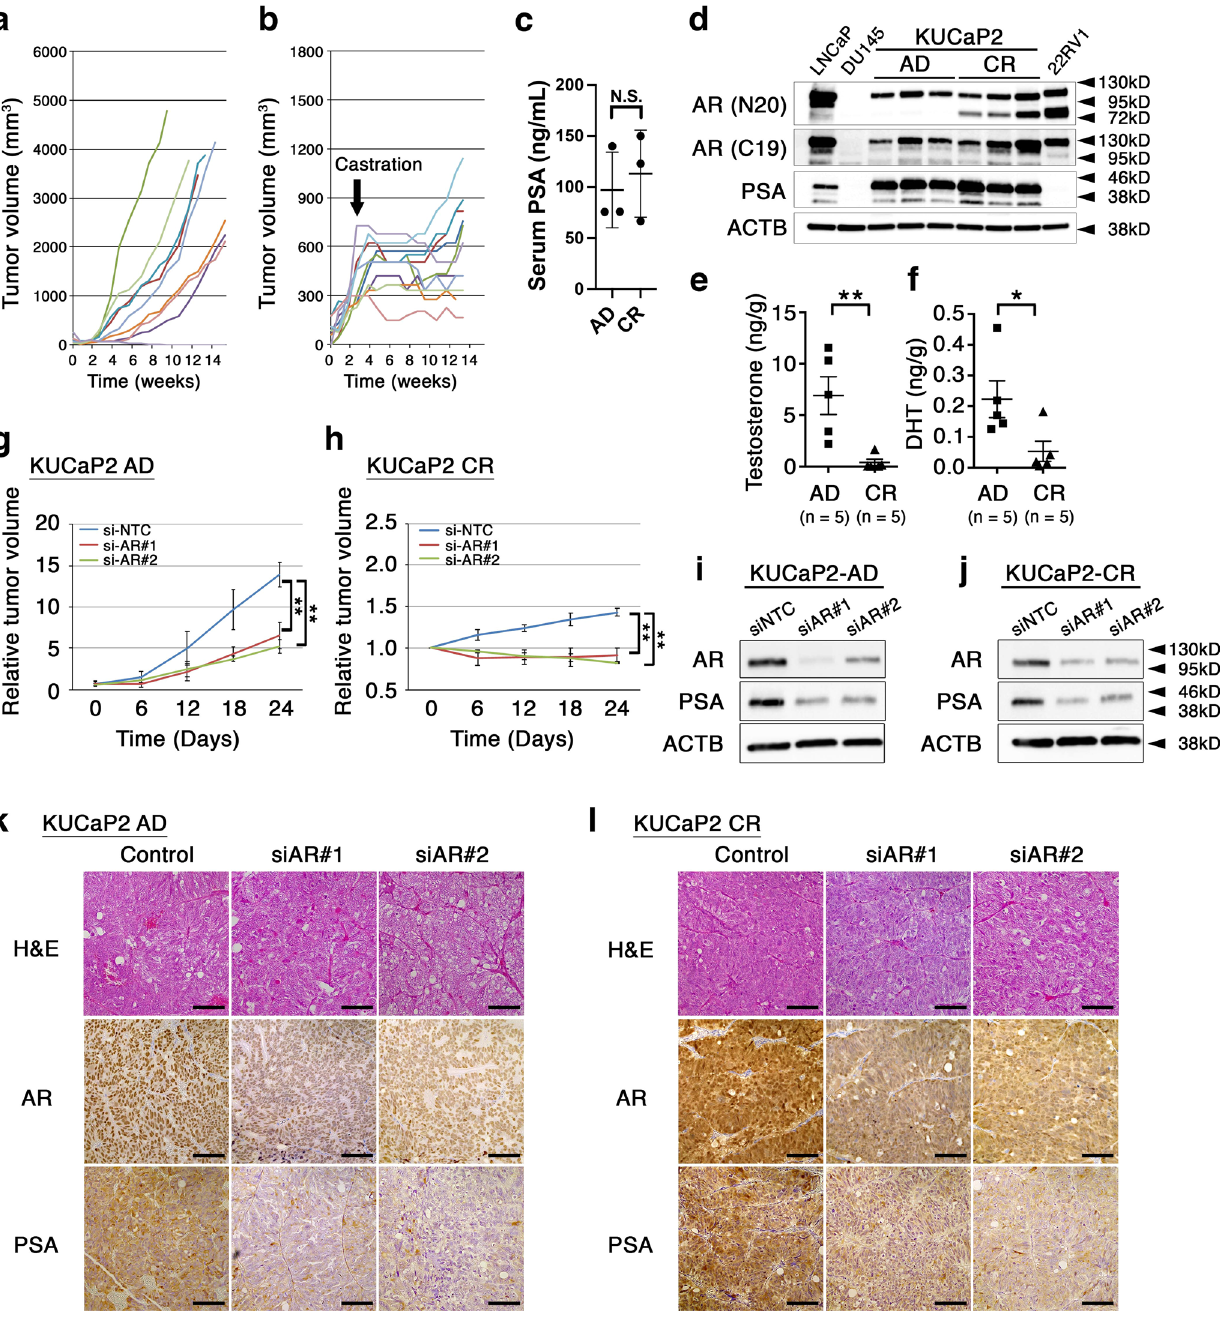
Fig. 1 KUCaP2 is a PDX line as a model for androgen receptor-dependent castration-resistant prostate cancer. a , b Individual growth curves of KUCaP2 tumors in intact ( a ) and castrated ( b ) mice. Arrow indicates surgical castration. c Serum prostate-speci fi c antigen (PSA) levels in androgen-dependent (AD) and castration-resistant (CR) tumor-bearing mice ( n = 4 each). d Western blotting of indicated proteins in AD and CR KUCaP2 tumors. Two antibodies for androgen receptor (AR) recognizing distinct epitopes on N-terminus (N20) and C-terminus (C19) were used. LNCaP, PC3, and 22RV1 prostate cancer cell lines act as controls. ACTB; β -actin. e , f Serum testosterone ( e ) and dihydrotestosterone (DHT, f ) levels in mice bearing AD and CR KUCaP2 tumors. g , h Growth curves of AD ( g ) and CR ( h ) KUCaP2 tumors treated with control (siNTC) or siRNAs for AR (siAR#1 and siAR#2). ** P < 0.01 (ANOVA). i , j Western blotting of indicated proteins in AD ( i ) and CR ( j ) KUCaP2 tumors treated with control or siRNAs for AR. k , l Representative microphotographs of hematoxylin and eosin (H&E) stain and immunohistochemical stains for AR and PSA in AD ( k ) and CR ( l ) KUCaP2 tumors treated with control or siRNAs for AR. Bars indicate 50 μ